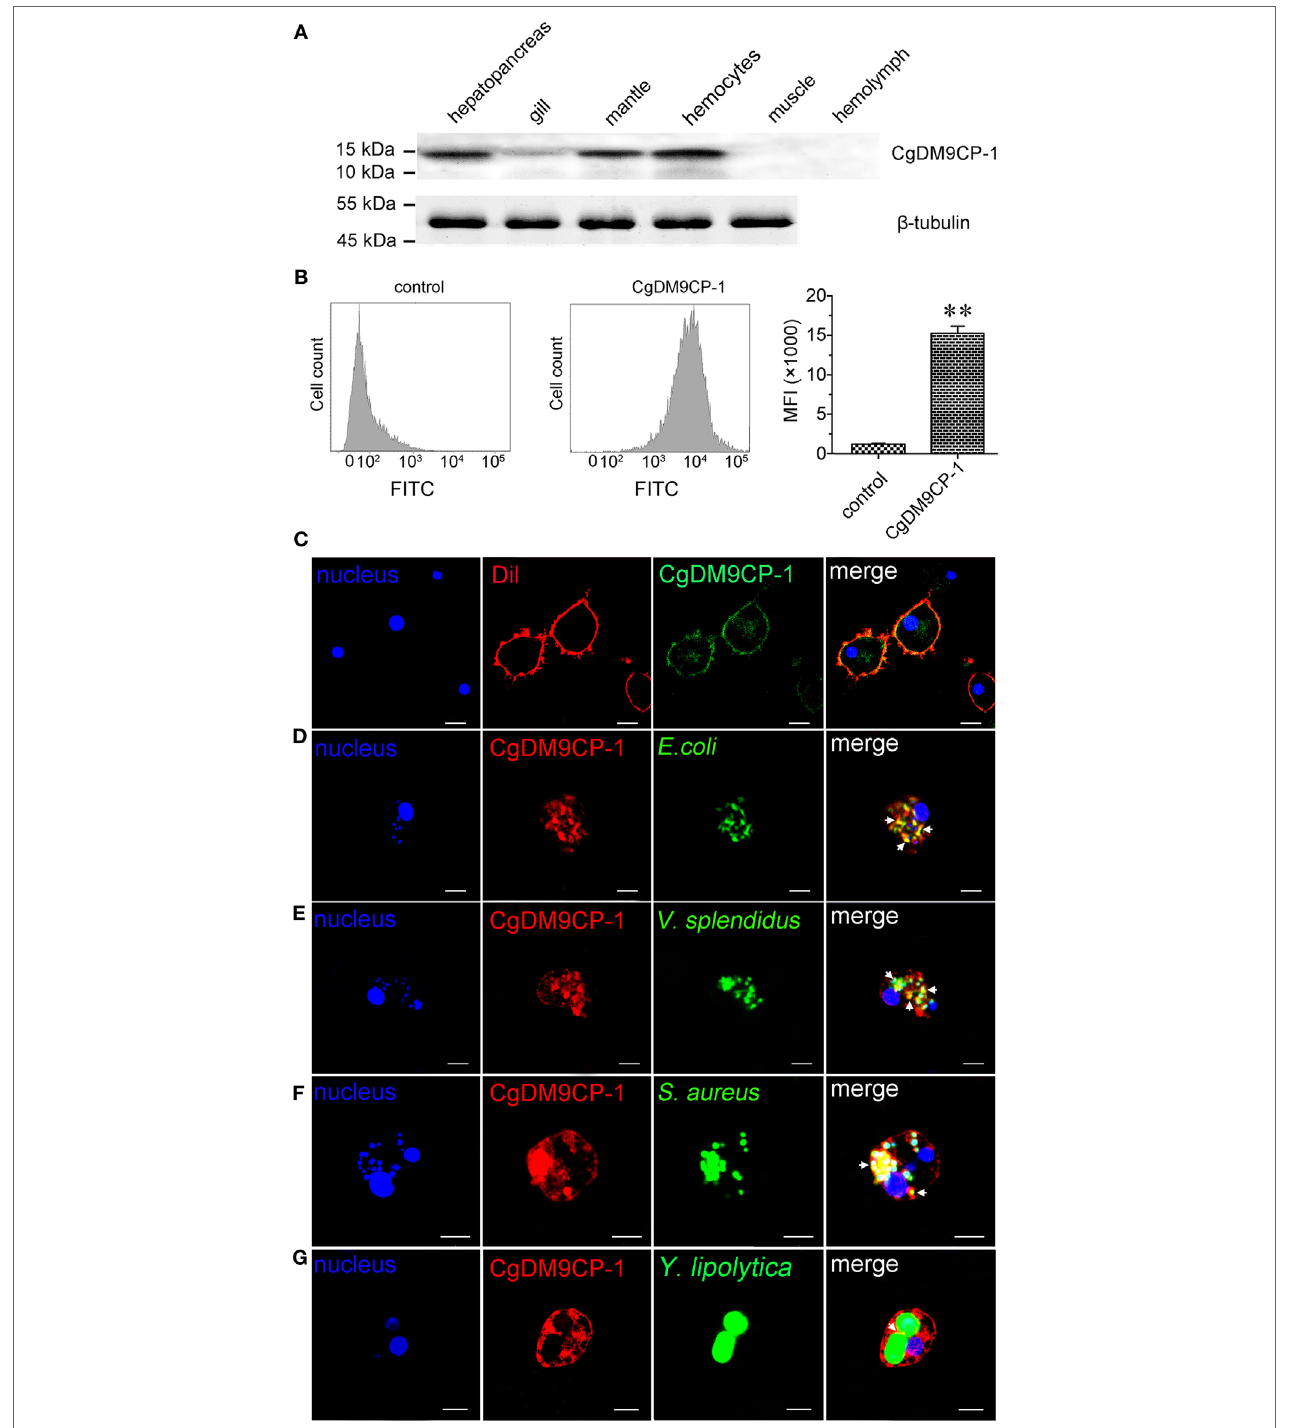
FigUre 5 | Crassostrea gigas DM9 domain containing protein 1 (CgDM9CP-1) was involved in the hemocyte phagocytosis toward microbes. (a) The expression profile of CgDM9CP-1 was detected by Western blotting. (B) The expression level of CgDM9CP-1 on hemocytes was determined by flow cytometry ( n = 5), and the data were representative of three independent experiments. ** P < 0.01. (c) Confocal analysis of CgDM9CP-1 distribution on hemocytes. Hemocytes were stained with polyclonal antibody against CgDM9CP-1 followed by Alexa Fluor 488-labeled antimouse immunoglobulin G (IgG) antibody staining. DAPI and Dil were used to stain cell nucleus and cell membrane, respectively. Hemocytes were incubated with FITC labeled Escherichia coli (D) , Vibrio splendidus (e) , Staphylococcus aureus (F) , and Yarrowia lipolytica (g) to allow hemocyte phagocytosis, and then stained with polyclonal antibody against CgDM9CP-1 and Alexa Fluor 594 labeled anti-mouse IgG antibody. DAPI was used to indicate cell nucleus. The interactions between CgDM9CP-1 and engulfed microbes were indicated with white arrows (D–g) . Bar: 5